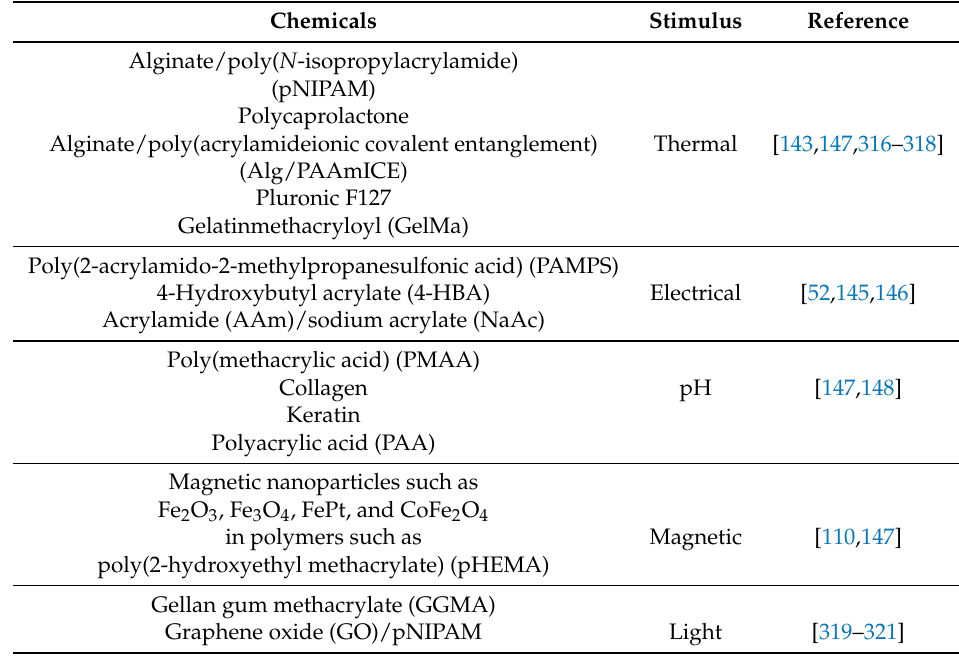
Table 5. Hydrogel-based 3D printing with different stimuli. Adapted with permission from [142]. Copyright 2016,